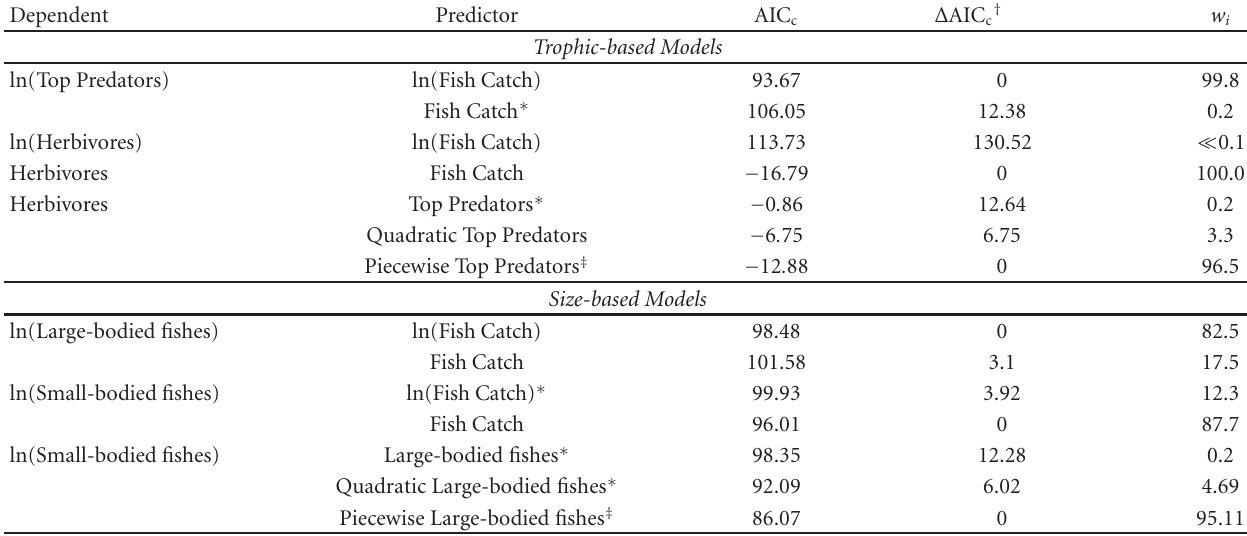
Table 2: Models of e ff ects of fishing on fish trophic group and size-class